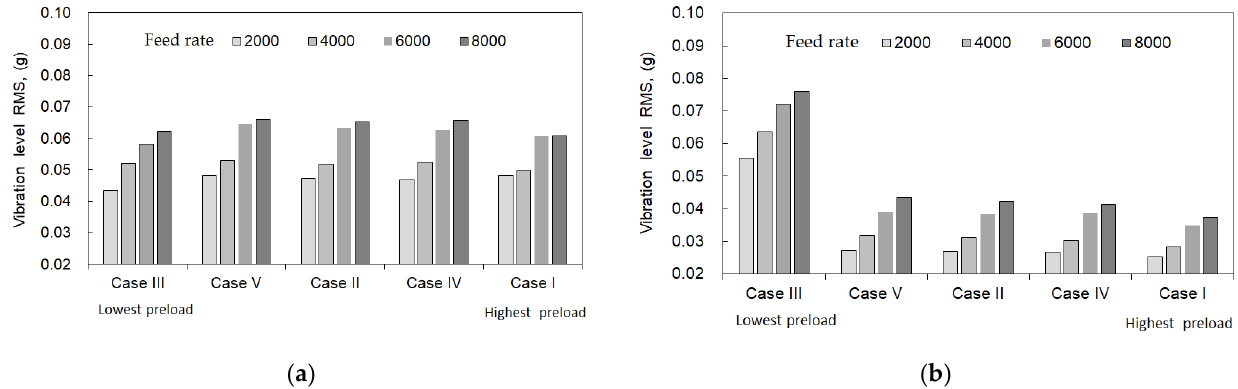
Figure 11. Relationship between the stage rigidity and vibration level at different feed rates: ( a ) sensors at mid-point of edge and center of the stage; and ( b ) sensors at corner of the stage.